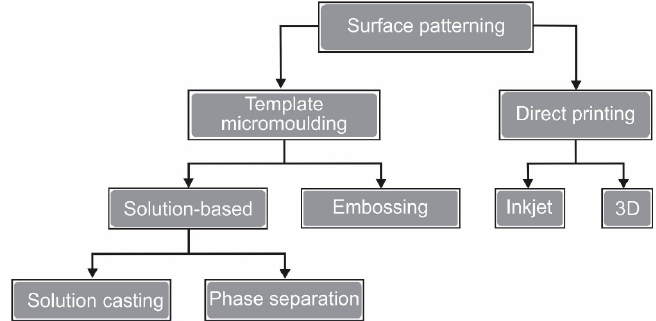
Figure 1. Classification surface patterning methods.